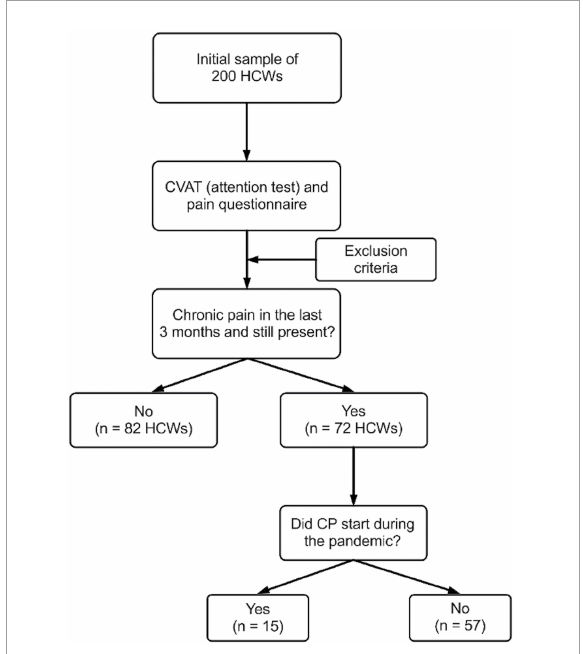
FIGURE2 Flowchart of the study design. HCWs, healthcare workers; CVAT, Continuous Visual Attention Test; CP, chronic pain.